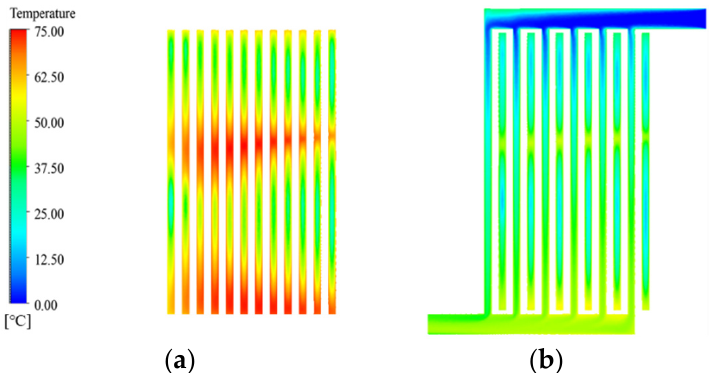
Figure 4. The fluid velocity distribution between MMC and MMDC structures. ( a ) Inlet side plane; ( b ) microchannels plane; ( c ) outlet side plane.